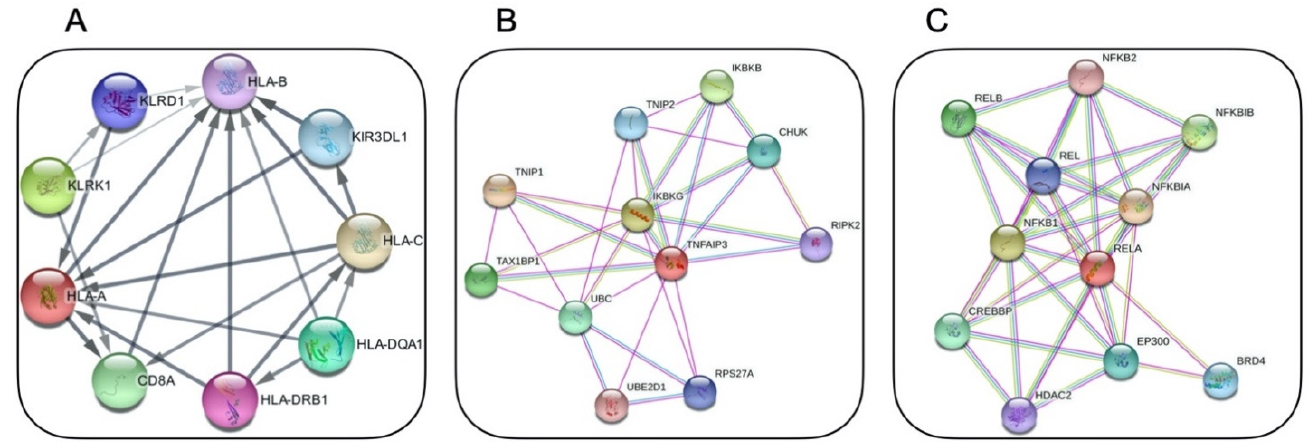
Figure 1. STRING app [39] physical subnetwork visualisation with Cytoscape Software [40] for: ( A ) HLA-B from within Behcet disease–related genes (the resulting network consists of 21 functional associations between 9 proteins with a confidence cut-off of 0.4 (PPI enrichment p -value: 7.02 × 10 − 7 )); ( B ) A20 protein (the resulting network consists of 29 functional associations between 11 proteins with a confidence cut-off of 0.4 (PPI enrichment p -value: 0.000522)); ( C ) RELA protein (the resulting network consists of 36 functional associations between 11 proteins with a confidence cut-off of 0.4 (PPI enrichment p -value: 1.11 × 10 − 7 )).